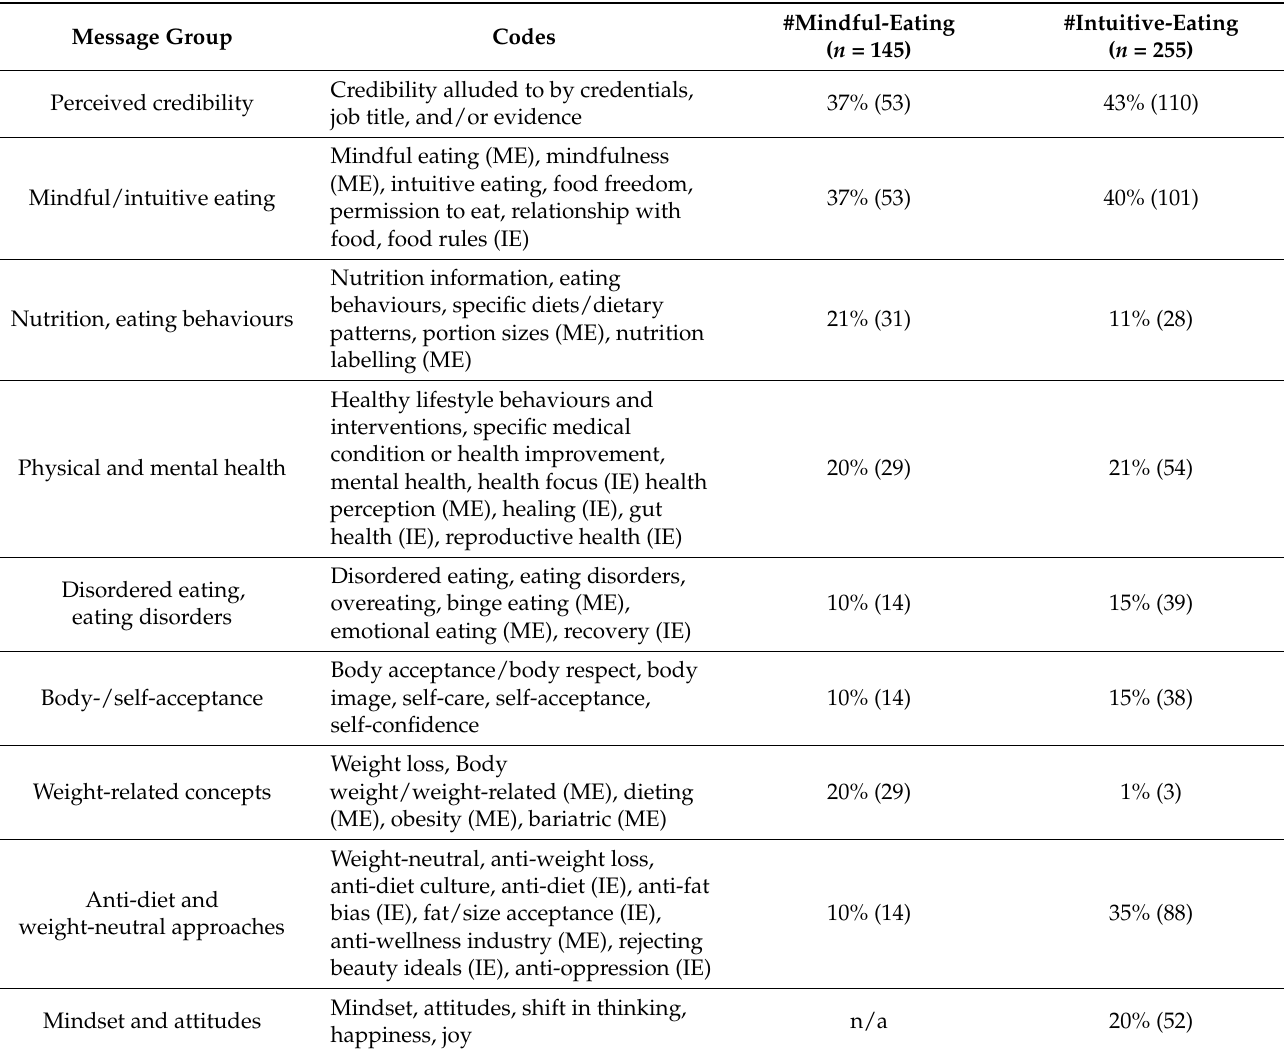
Table 2. Summary of textual content categorized under #mindfuleating and #intuitiveeating on Instagram, as percentages of images with textual messaging in